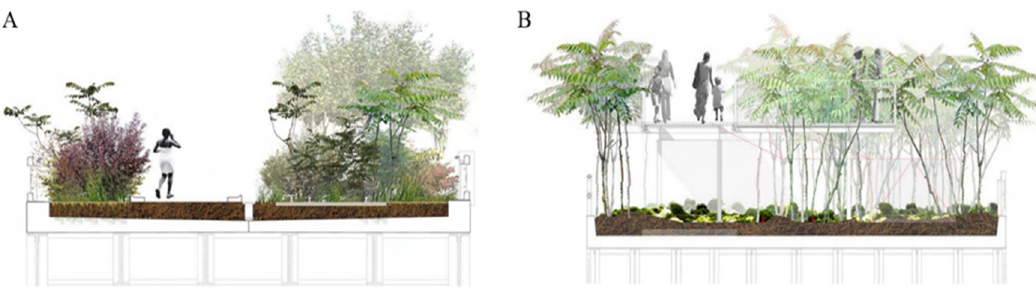
Figure 7. The High Line: ( A ) cross-section of the main pathway; ( B ) cross-section of a multi-level zone. Reprinted from ref. [50].